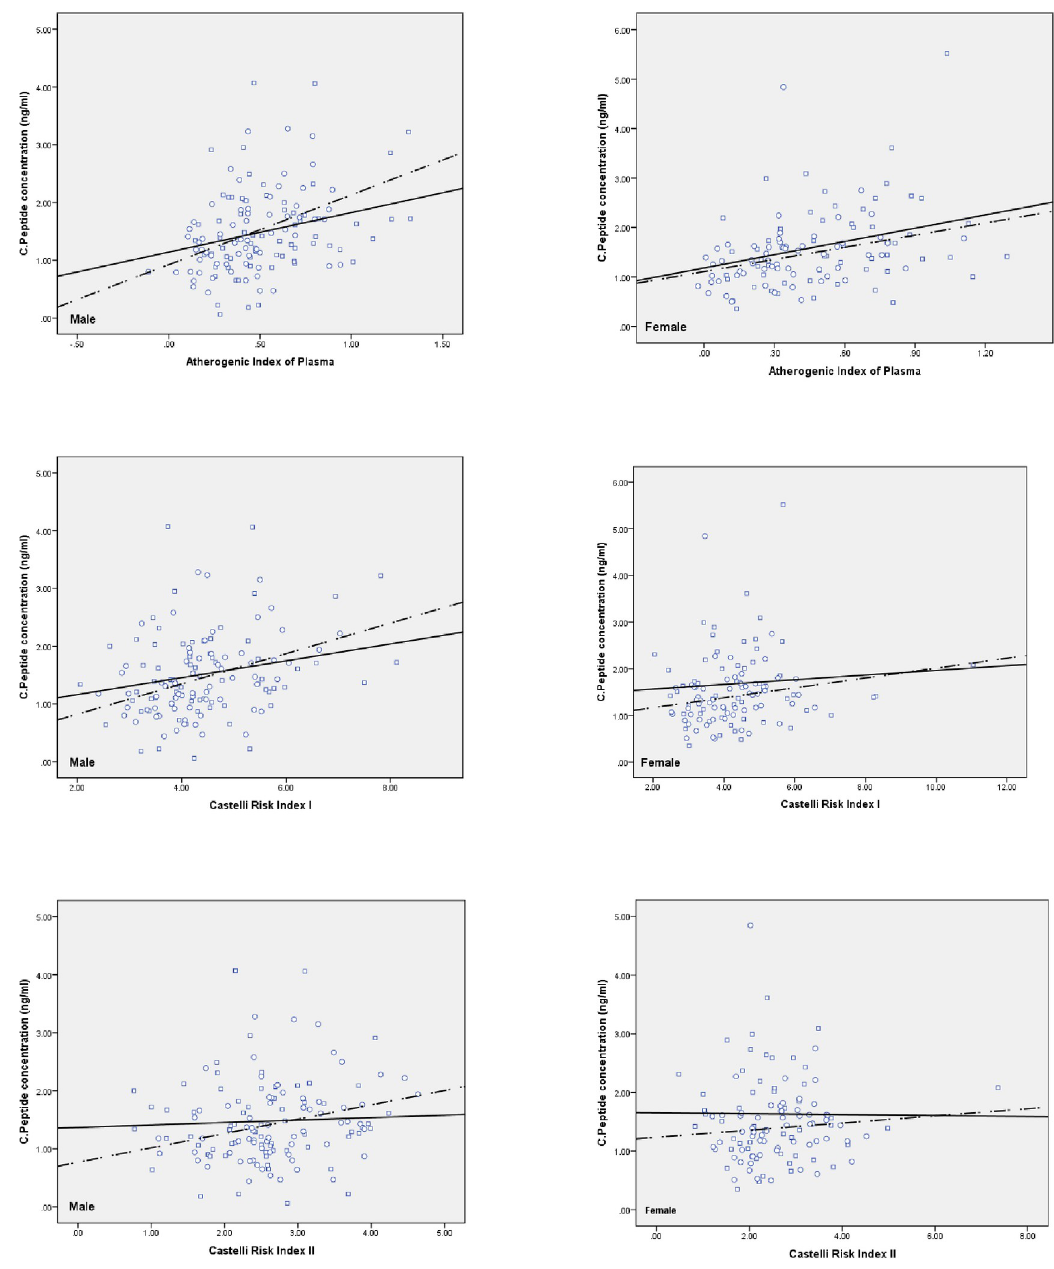
Fig 2. Correlation of C-Peptide with atherogenic indices of plasma¶ according to both genders. Control: circle; Case: square; Control regression line: dashed line; Case regression line: solid line. Atherogenic Index of Plasma (AIP); Castelli Risk Index I (CRI I); Castelli Risk Index II (CRI